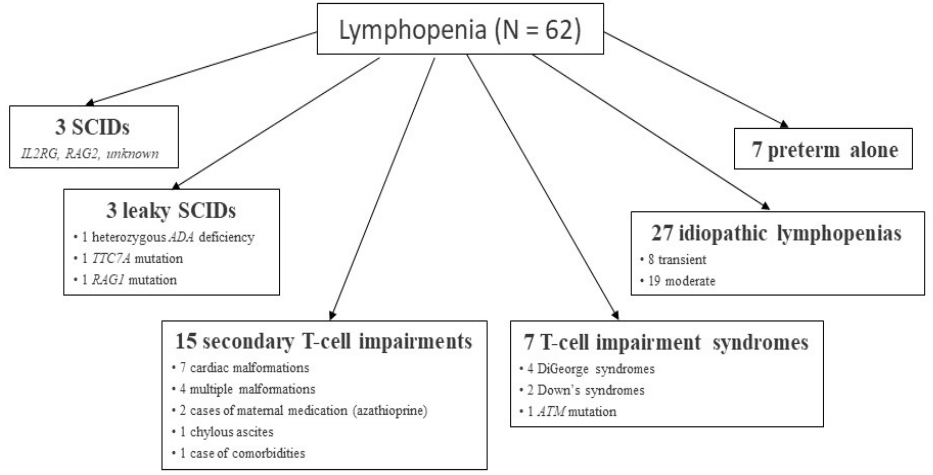
Figure 3. Description of 62 cases of lymphopenia.